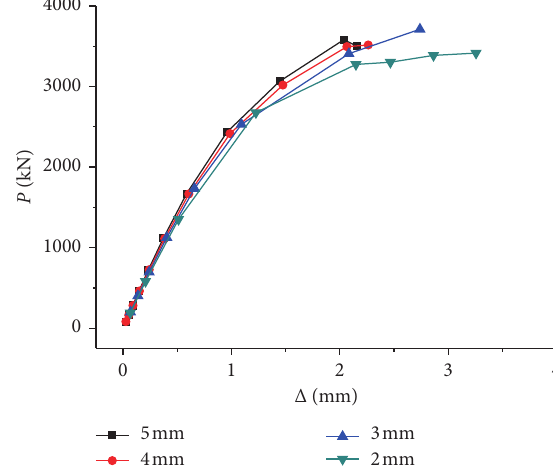
Figure 15: Influence of steel wall thickness on specimen performance.